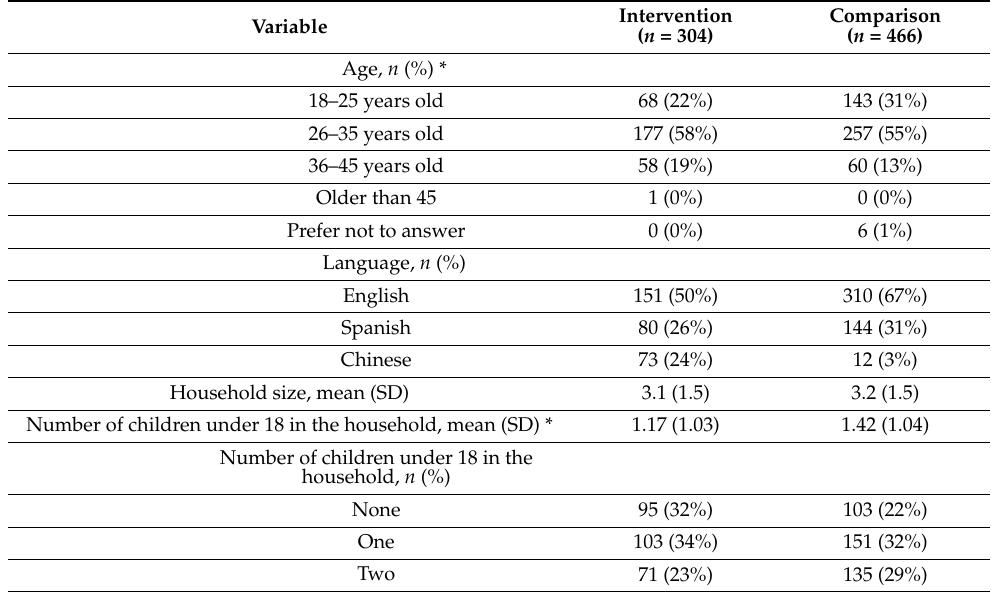
Table 1. Participant characteristics at